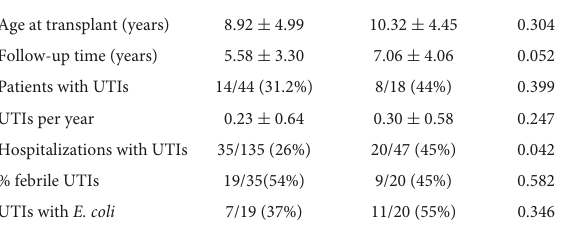
TABLE 5 Male vs. female: urinary tract infection (UTI) rates and